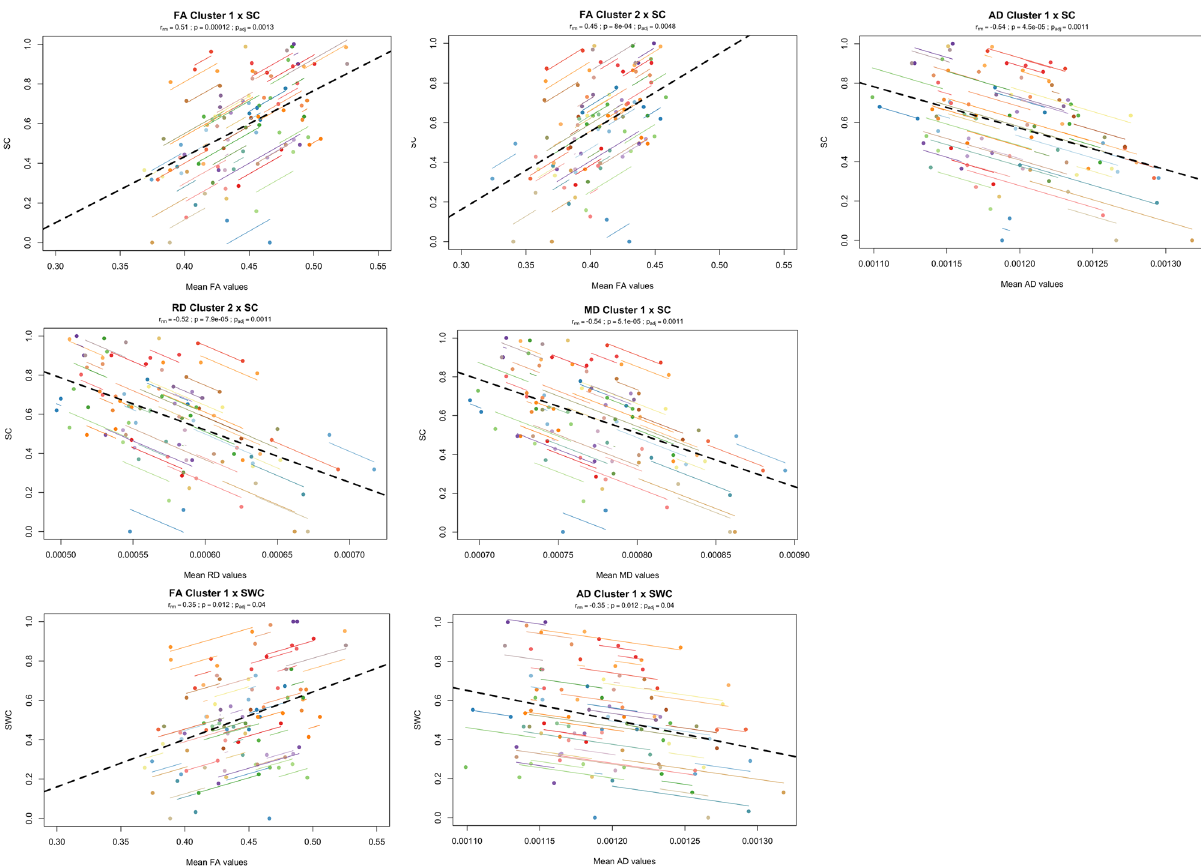
Figure 4. Significant repeated measures correlations between Stroop test variables (Stroop colors – SC, Stroop words/colors – SWC) and DTI metrics (FA, AD, RD and MD) of clusters with significant changes between timepoints. The x-axis represents average values of each DTI metric and y-axis, the average values of SC/SWC. Observations from the same individual are represented with the same color, with corresponding lines showing the repeated measures correlation fit for each subject. Dashed black line represents the overall regression line. All clusters, with the exception of RD cluster 1, were significantly associated with SC. For FA clusters, we found a positive correlation, meaning that higher FA values are associated with higher LTS scores. For AD, RD and MD clusters, a negative correlation was found, showing that lower AD, RD or MD values are associated with higher SC scores. Regarding SWC, FA cluster 1 was positively correlated and AD was negatively correlated. Overall, these results suggest that higher WM integrity is associated with higher cognitive performance in the executive function